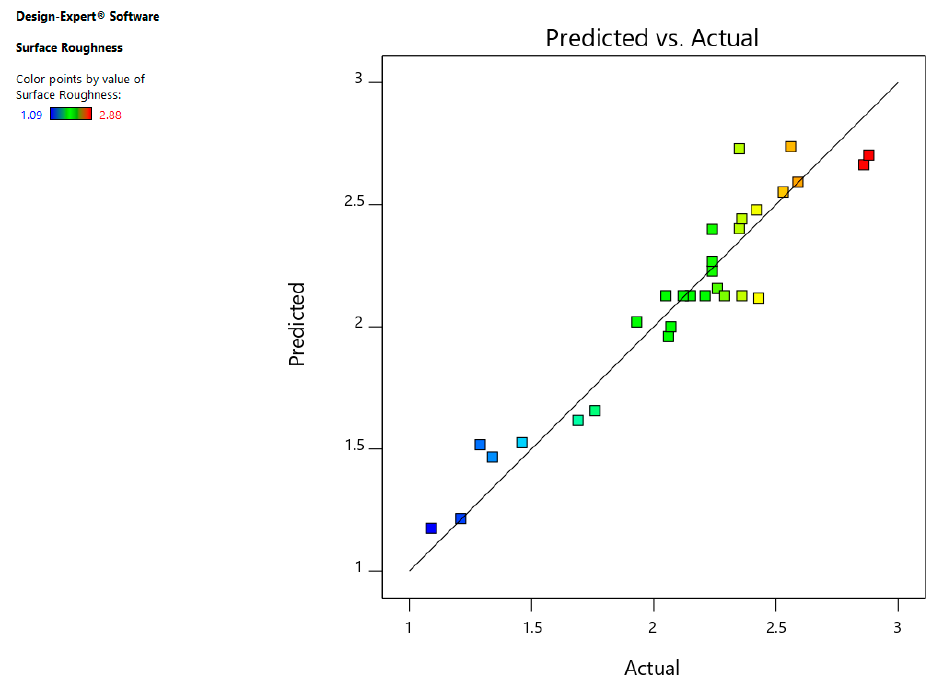
Figure 10. Predicted vs. actual plot for SR.